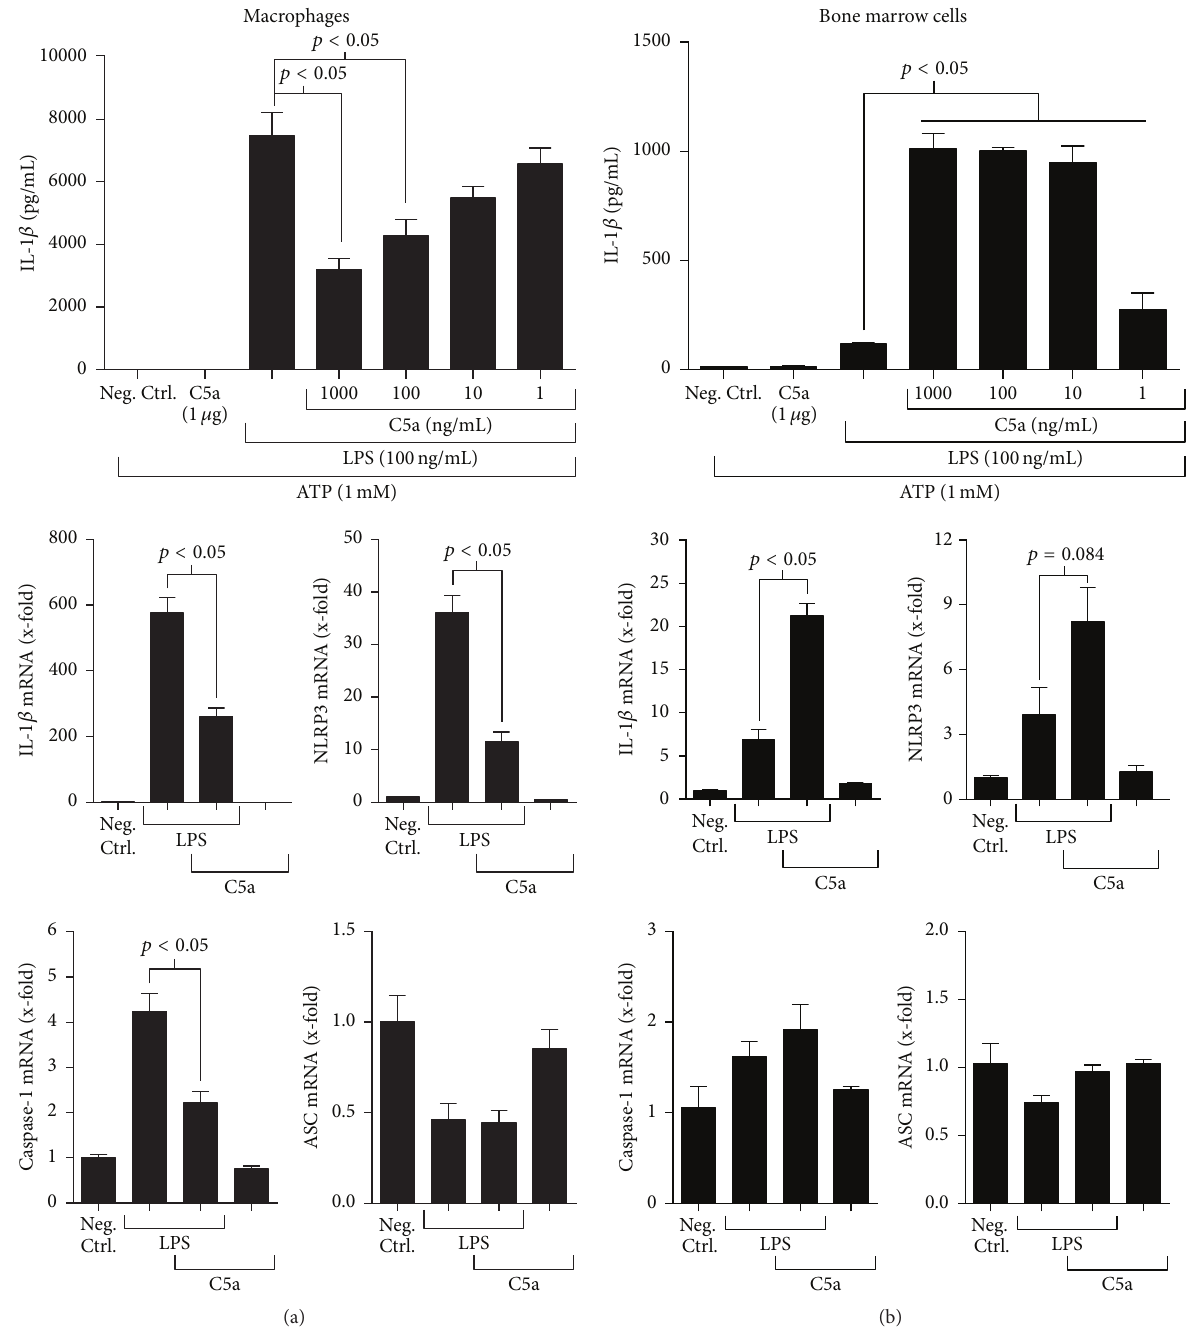
Figure 2: C5a suppresses NLRP3 function in macrophages but augments LPS-primed IL-1 𝛽 production in bone marrow cells. For quantifying IL-1 𝛽 release, 1 × 10 6 thioglycollate-elicited peritoneal macrophages (a) or total bone marrow cells (b) were harvested, treated with LPS (100ng/mL) in the absence or copresence of varying C5a concentrations for 4 hours, and then stimulated with ATP (1mM) for 45 minutes to achieve NLRP3 inflammasome activation. IL-1 𝛽 levels in cell-free supernatants were determined using ELISA (top panels). qRT-PCR assays (middle and bottom panels) were performed on mRNA isolated from 1 × 10 6 peritoneal macrophages (a) or bone marrow cells (b) 4 hours after culture with or without LPS (100ng/mL) in the presence or absence of C5a (1,000 ng/mL). ATP treatment was not performed for mRNA quantification experiments. Relative expression levels of inflammasome component genes (indicated as fold change) were normalized to GAPDH expression and calculated using the 2 −ΔΔ Ct method. ELISA and qRT-PCR data are shown as mean values ± standard error of the mean. Experiments were performed in triplicate for ≥ 2 independent experiments, and representative data are shown. Results indicated that C5a attenuates TLR4-mediated macrophage IL-1 𝛽 production but enhances NLRP3 function in bone marrow cells. Neg. Ctrl. = negative (unstimulated)